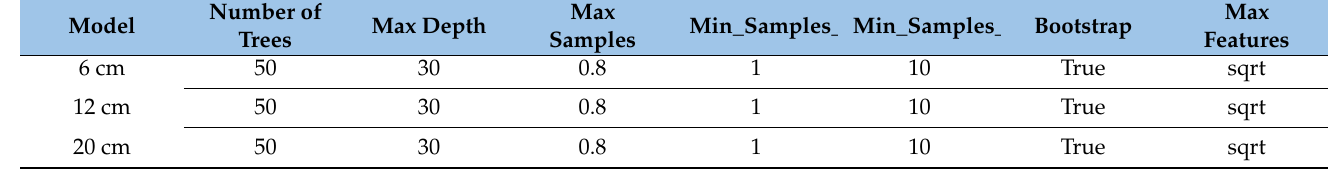
Table A2. Final hyperparameters for the random forest model runs after the grid search